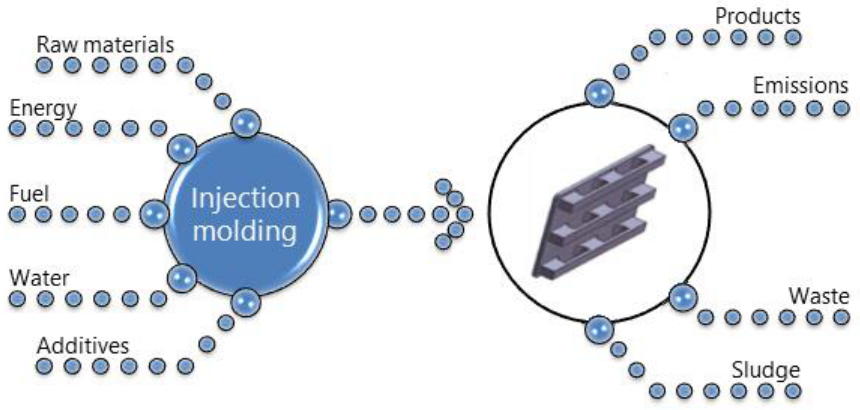
Figure 1. Scheme showing scope of performed analysis.